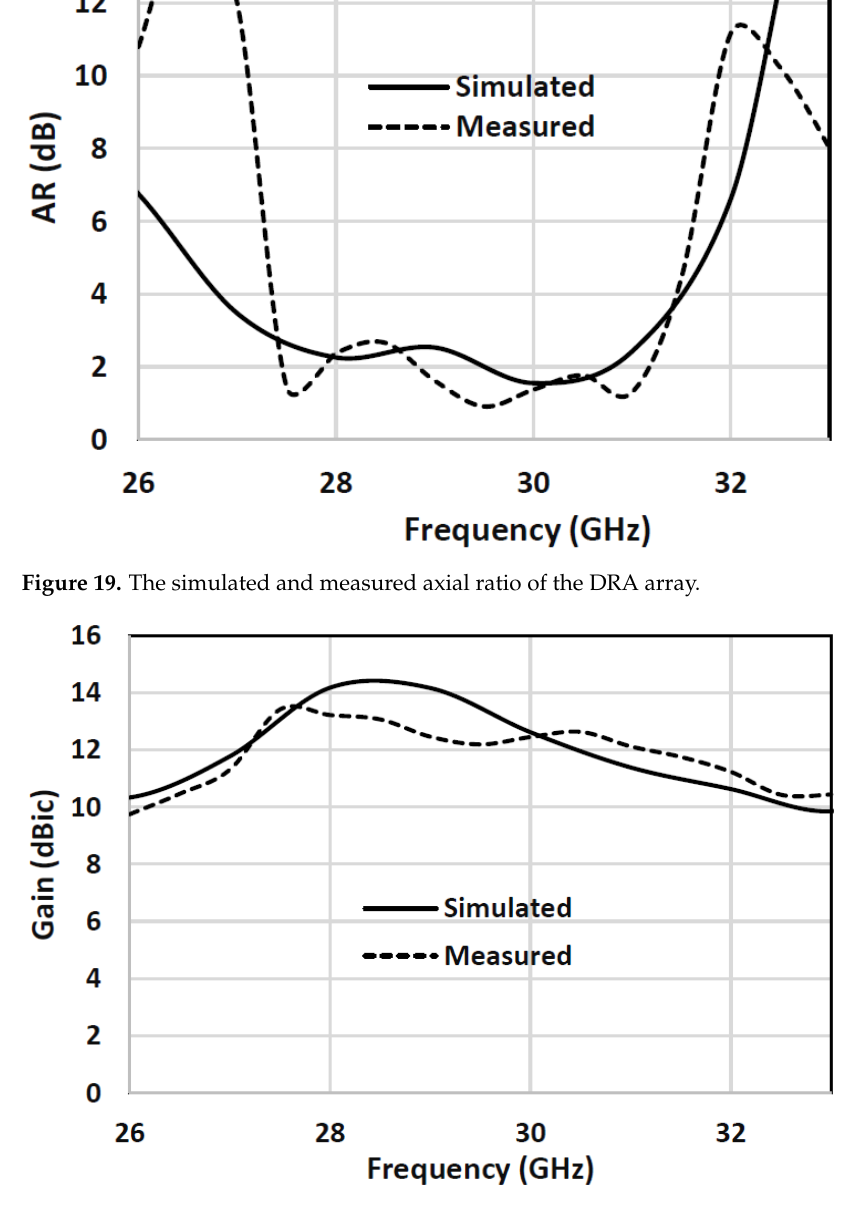
Figure 20. The simulated and measured gain of the DRA array.